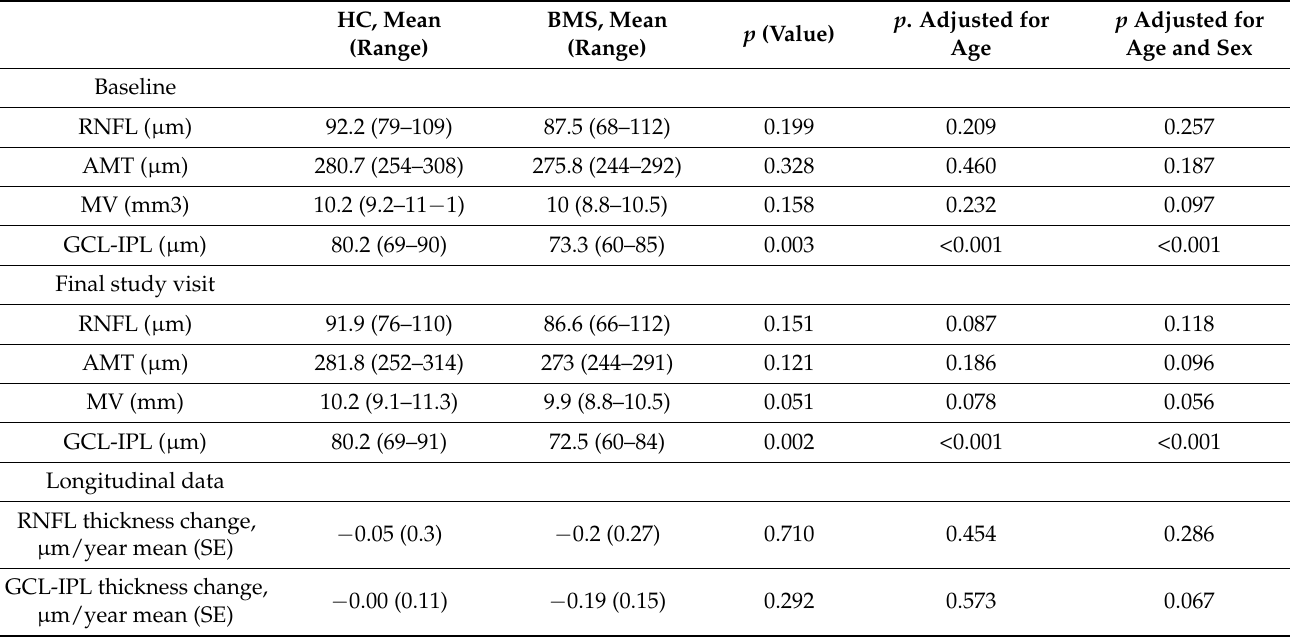
Table 4. OCT measures of best eye from BMS and control